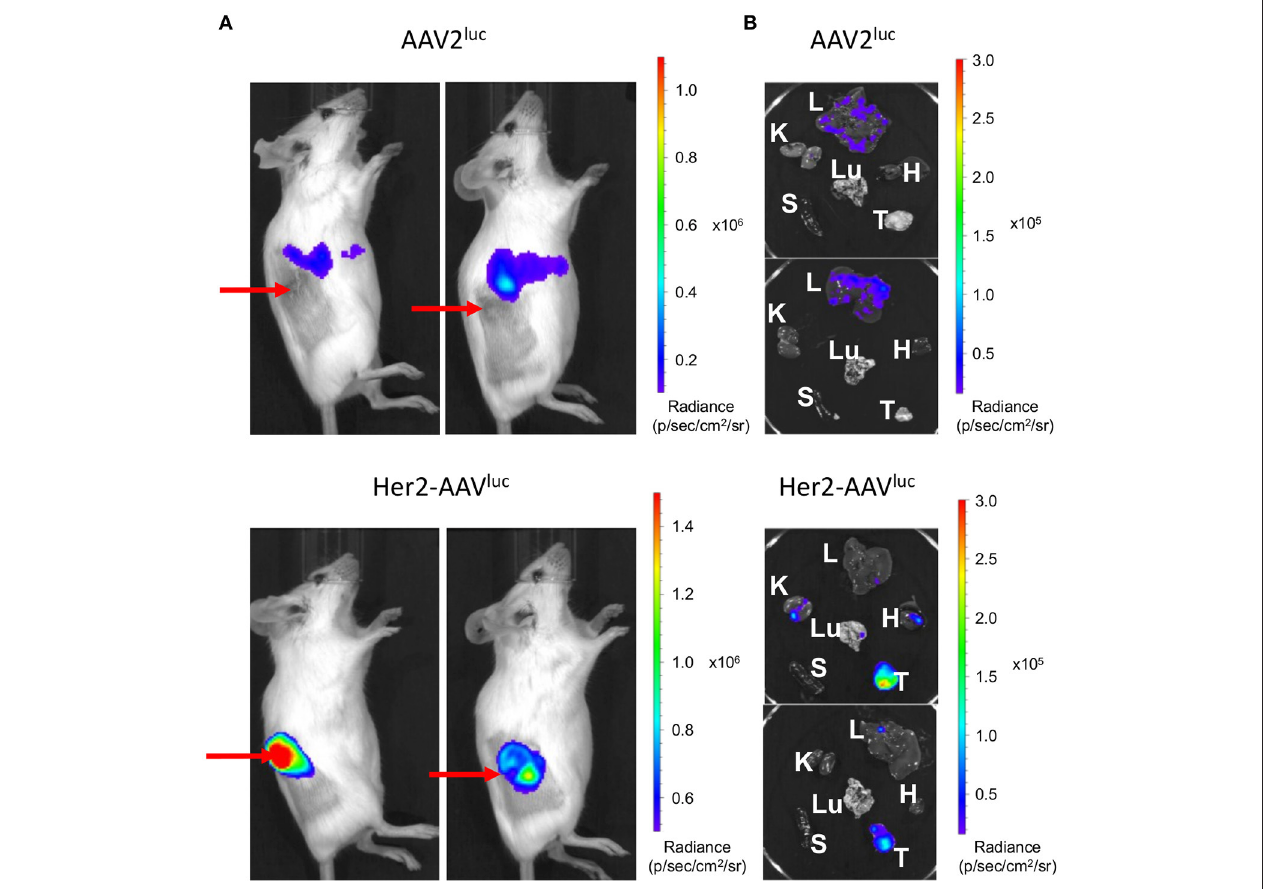
FIGURE 3 | Tumor targeting by Her2-AAV in immunocompetent mice. 5 × 10 6 RENCA-Her2/neu tumor cells were implanted subcutaneously into the flank of BALB/c mice. AAV targeting was analyzed by in vivo imaging one week after intravenous injection of 1 × 10 11 genome copies of AAV2 luc or Her2-AAV luc . Luciferase signal intensity is expressed as photons/second/square centimeter/steradian (p/sec/cm 2 /sr). Luciferase expression was analyzed in living mice (A) and in isolated organs (L, liver; K, kidney; H, heart; Lu, lung; S, spleen; T, tumor) (B) . Red arrows point to subcutaneously growing tumors.